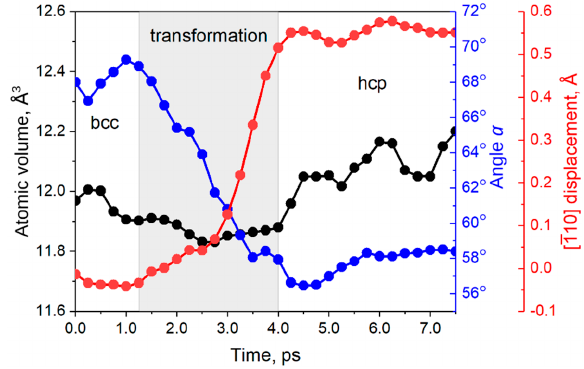
Figure 19. Three adjacent (110) planes (upper row) and projections of the analyzed cell around atom B onto the (110) plane (middle row) and the (001) plane (lower row) at the time instants 0.00 ( a ), 3.25 ( b ), 3.75 ( c ), and 5.00 ps ( d ). The size of atoms corresponds to their position in the bcc (110) planes numbered I, II, and III. Atoms with bcc, fcc, and uncertain nearest neighbor symmetry are shown in blue, green, and gray, respectively. The inset in ( a ) exhibits the initial 3D view of the analyzed atomic cell, where gray solid lines represent the edges of the bcc Bravais cell.